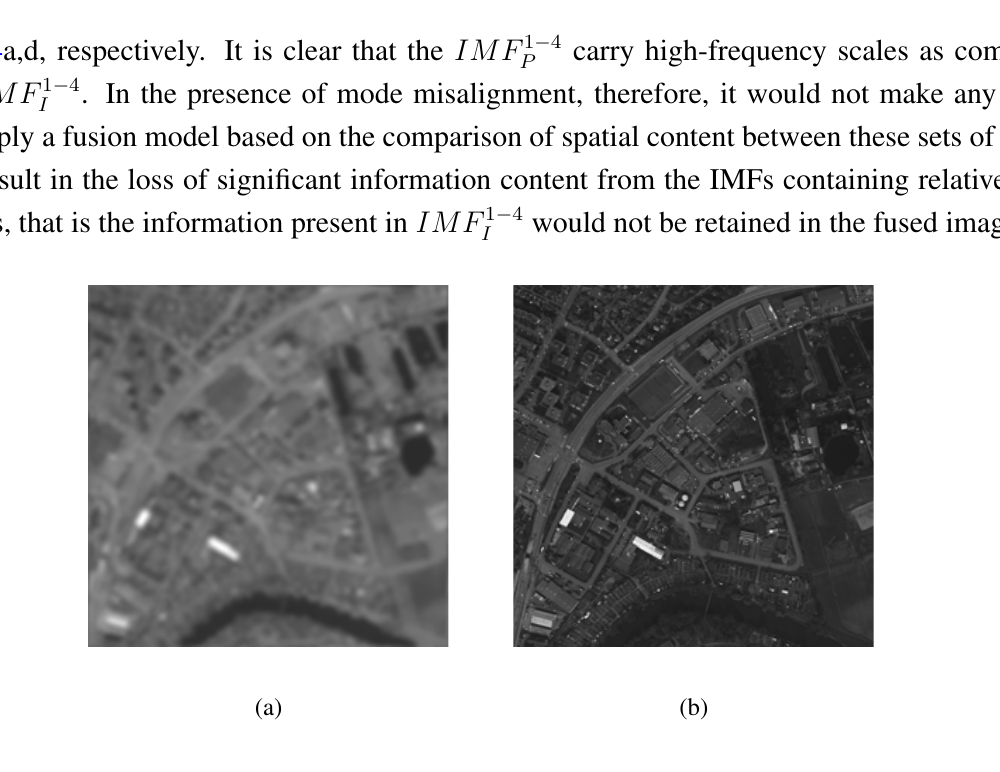
Figure 3. The intensity plane I of the low-resolution multispectral (MS) and the high-resolution panchromatic (PAN) images used to demonstrate mode mixing and mode misalignment in EMD. ( a ) The MS image; ( b ) the PAN image.